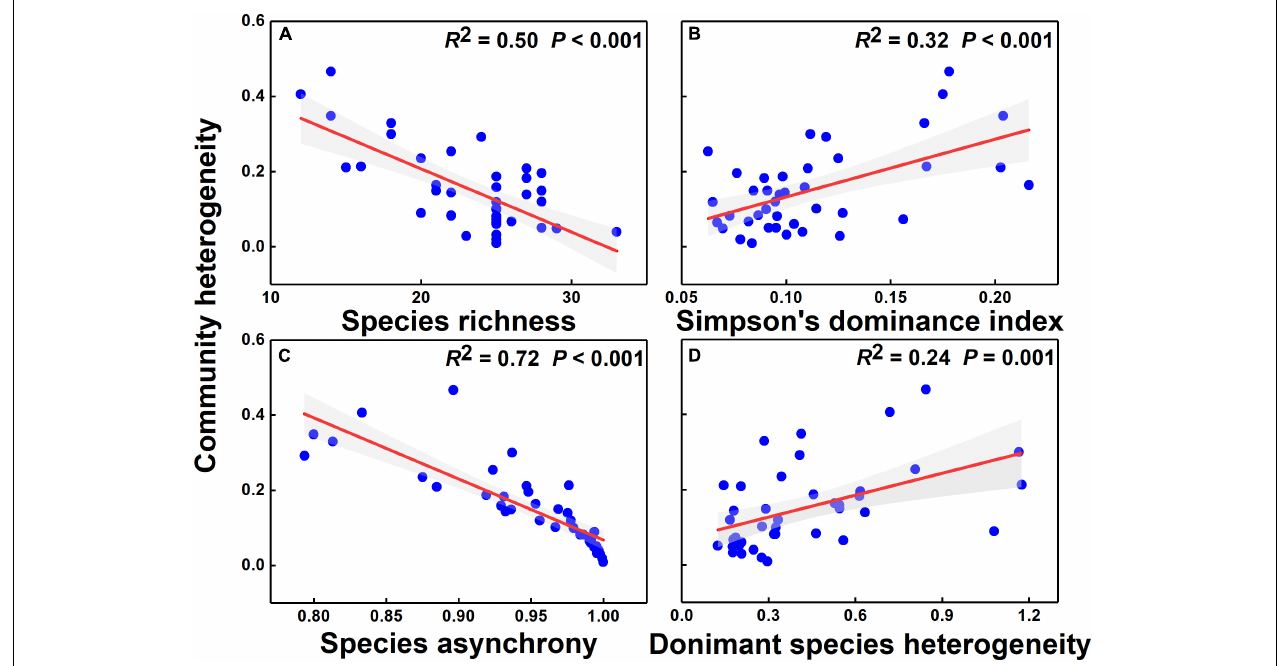
FIGURE 5 | The relationships of species richness (A) , Simpson’s dominance index (B) , species asynchrony (C) , and dominant species heterogeneity (D) with community heterogeneity. Red solid lines represent regression lines, and gray areas are 95% confidence intervals.